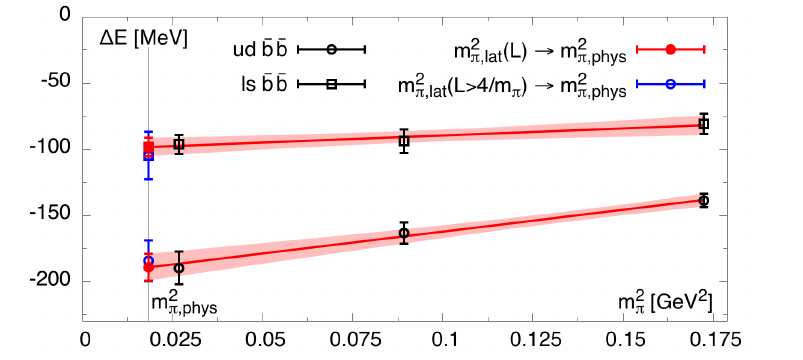
Figure 1. Chiral extrapolations of the ud ¯ b ¯ b and (cid:96) s ¯ b ¯ b binding energies. Red lines and points show the extrapolations using all three ensembles, the blue points those using m π = 415 MeV and m π = 299